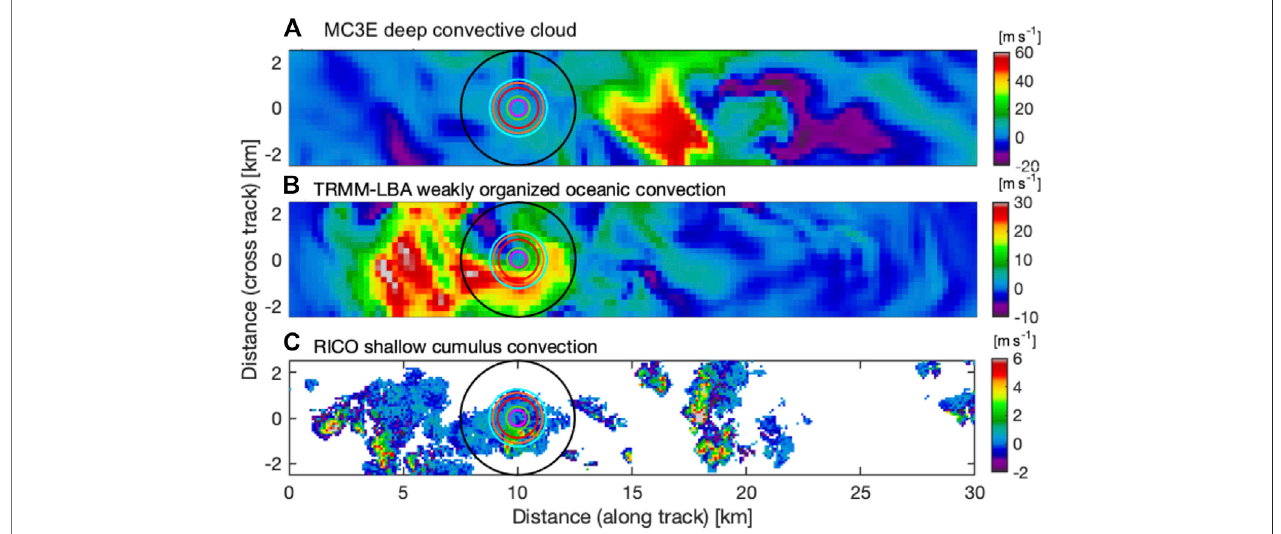
FIGURE 1 | Horizontal cross-section showing vertical air motion (V AIR in ms − 1 ; positive indicates upward motion) from three different model simulations: (A) MC3E at 12 km height, (B) TRMM-LBA at 10 km height, and (C) RICO at 1 km height. Overlaid circles represent the instantaneous fi eld of view (IFOV) of the six radars under consideration (color coded as in Table 1